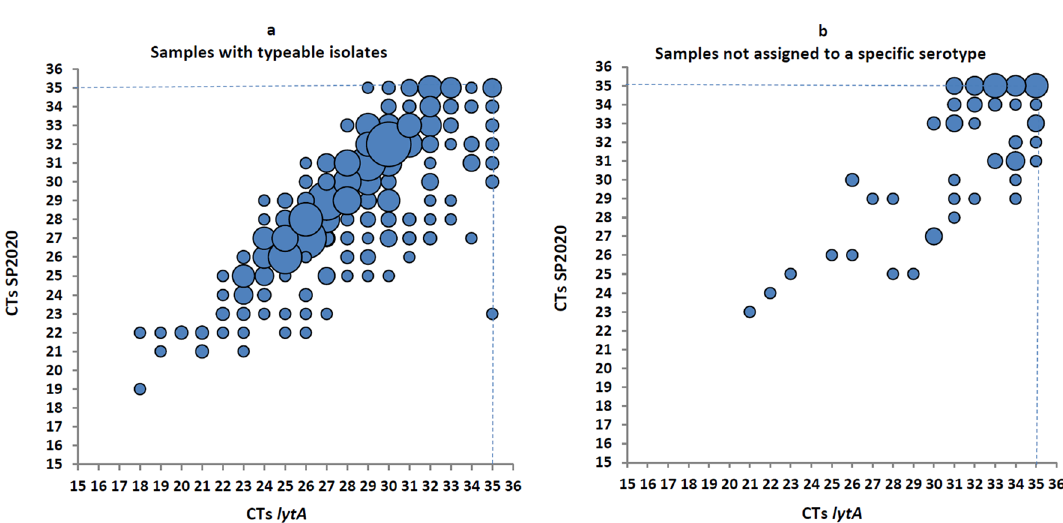
Figure 5. Samples tested positive for both genes: typeable (n = 424) ( a ) and samples not assigned to a specific serotype (n = 84) ( b ). Each blue circle indicates the CT values of samples tested positive for both lytA and SP2020 genes. The size of the blue circles (‘bubbles’) is proportionate to the number of samples which presented with the specific CT